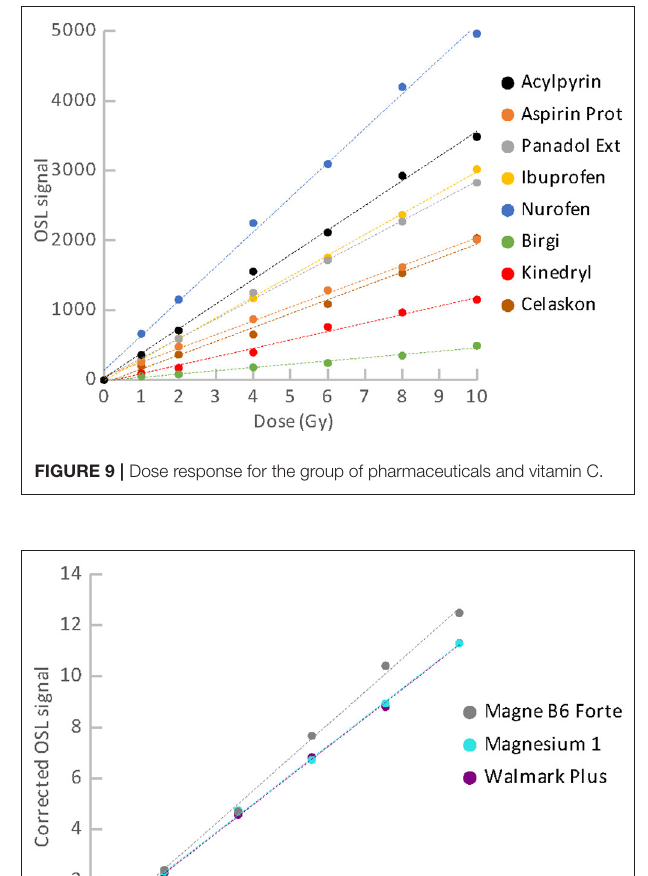
not exactly the same for different aliquots of the same